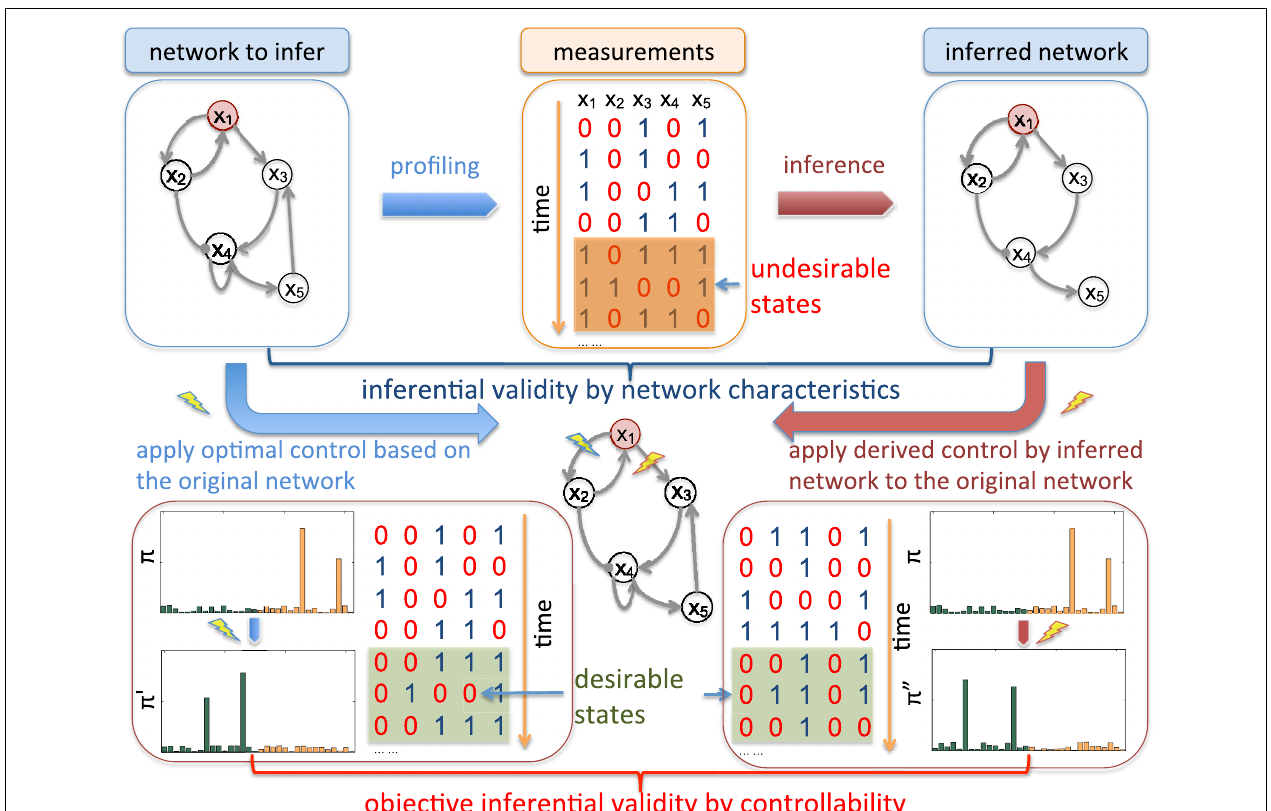
FIGURE 1 | Schematic illustration of inferential validity. There are different criteria to evaluate inferred networks from available temporal measurements. For example, we can directly measure the difference of inferred regulatory relationships among genes by the commonly adopted Hamming distance between the original network adjacency matrix and the inferred adjacency matrix. We are interested in objective-based inferential validity based on controllability. For example, assuming that x 1 is a genetic marker marked in red, the network is considered in “undesirable” states when it is up-regulated ( x 1 = 1). Hence, from the translational perspective, the ultimate goal of studying this network system is to develop effective therapeutic strategies based on collected data from the system. Hence when evaluating network inference algorithms, instead of comparing other network characteristics, it may be more appropriate to directly investigate how the derived intervention strategies based on inferred networks perform on the